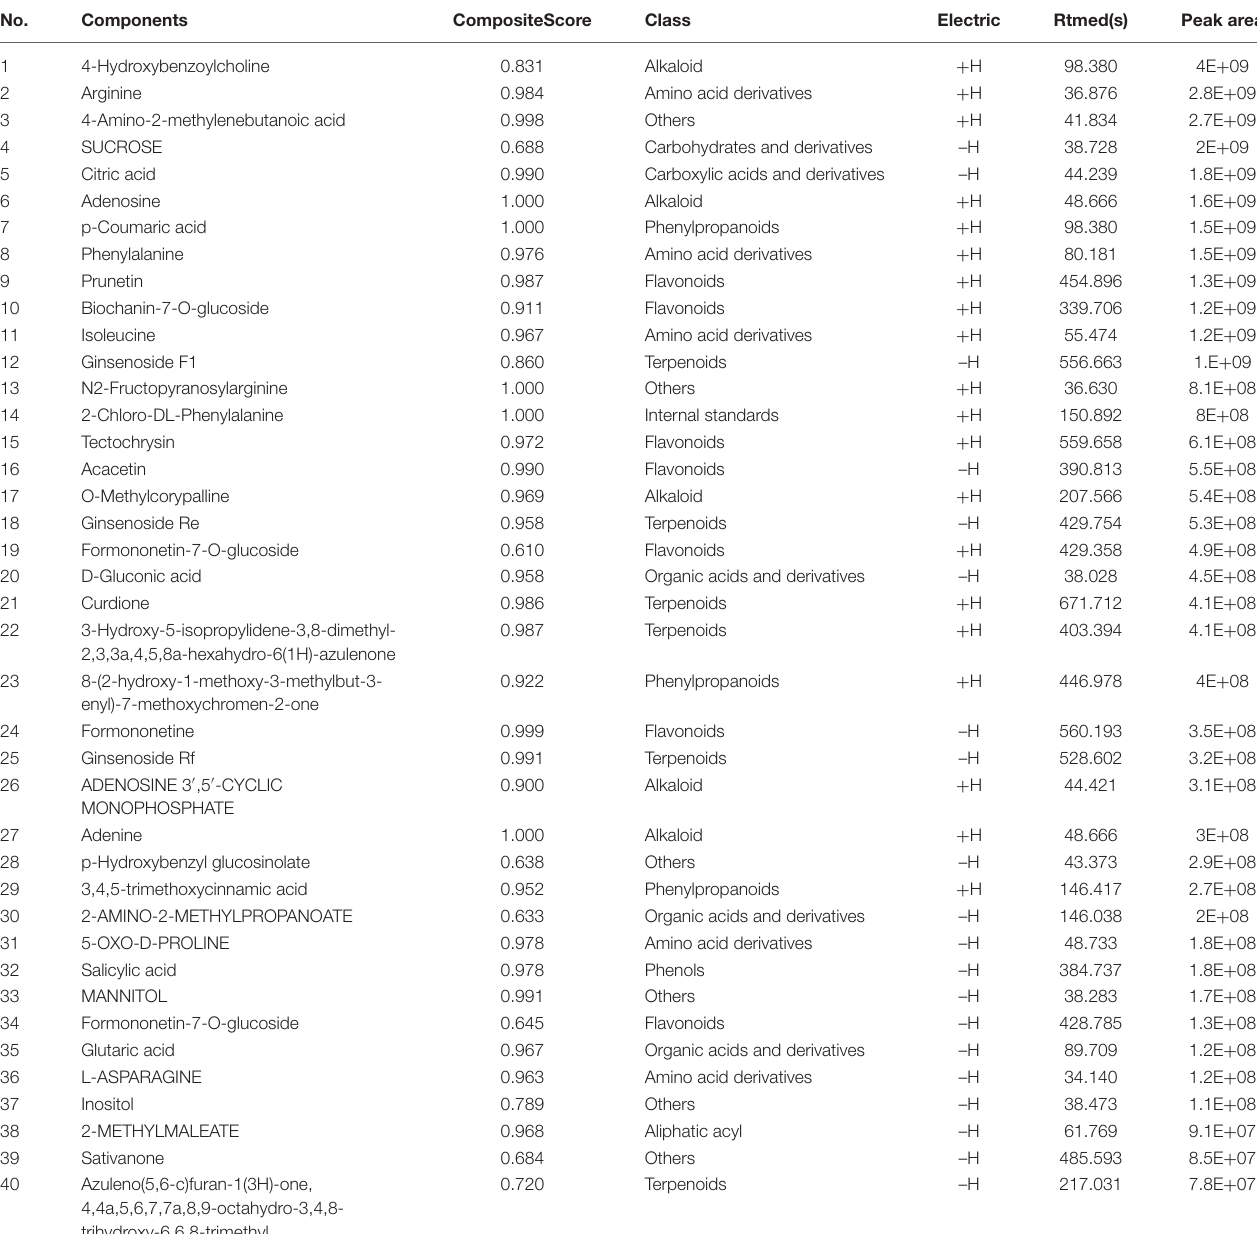
TABLE 2 | Screening the top 20 components of YS with UHPLC-QTOF-MS.